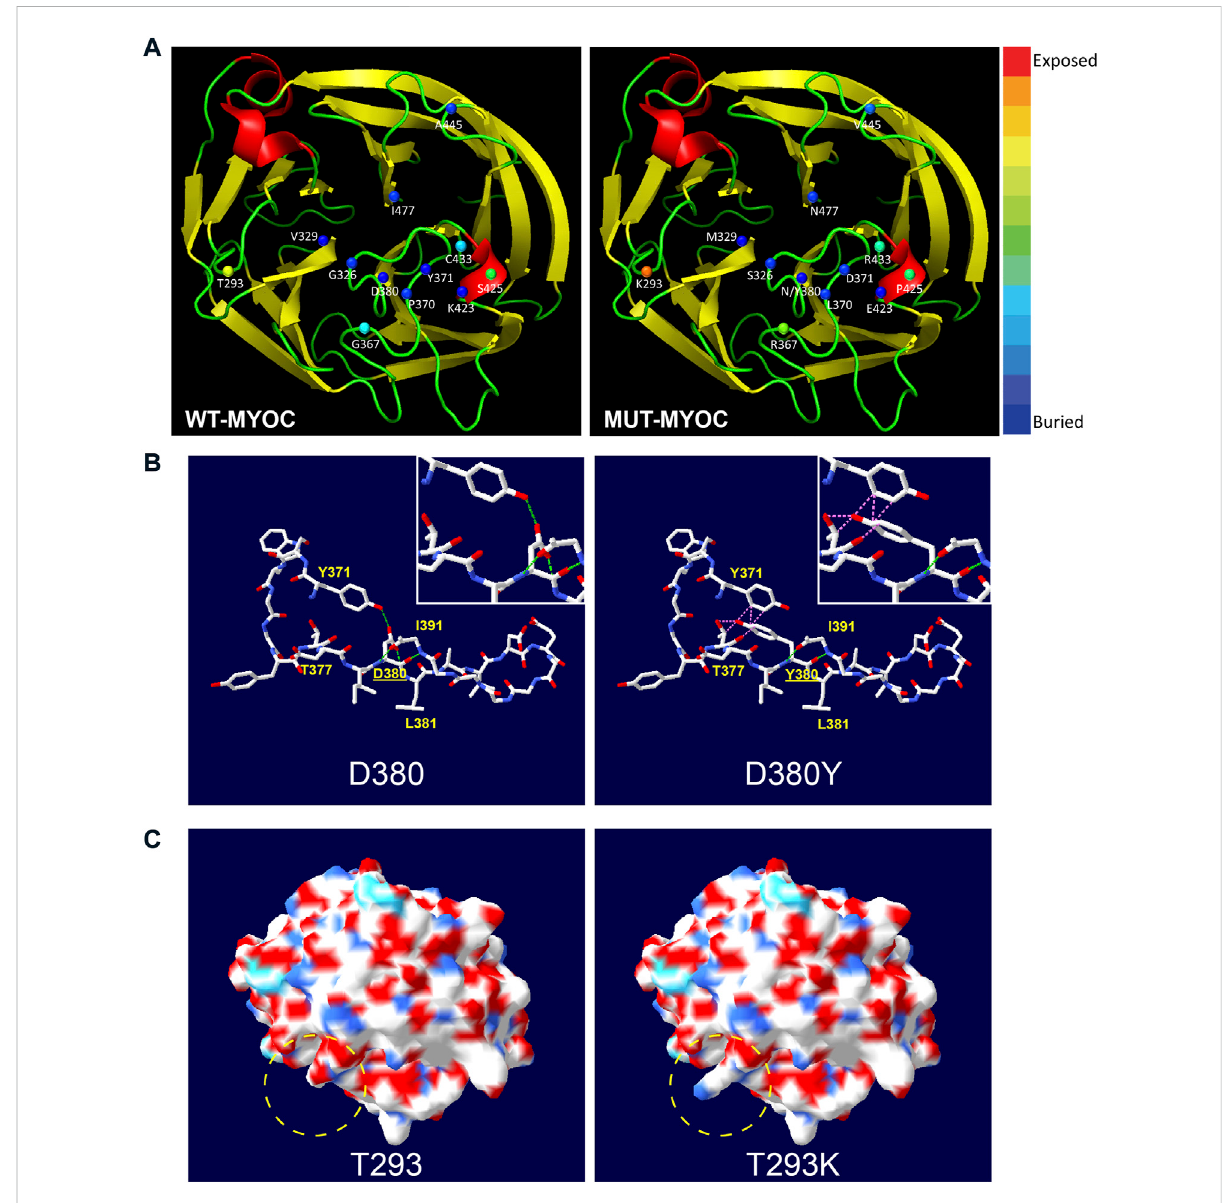
FIGURE 3 Structural alteration of myocilin-OLF induced by C-terminal MYOC variations using Swiss PdB Viewer. (A) Solvent accessibility analysis of WT- myocilin(leftpanel)andmutated-myocilin(rightpanel).Acartoonviewofthemyocilin-C-terminushomology(PDB:4WXQ)modelisshown.Twelve residues involved in 13 missense changes are represented as spheres colored according to solvent accessibility (using Swiss PdB Viewer, by which blue through red correspond to buried-through-exposed residues; see color bar). (B) Alteration of H-bonds and steric clashes induced by MYOC/p.D380Y mutation. H-bonds are drawn as green dotted lines, and clashes appear as pink dotted lines. (C) Changes in molecular surface including electrostaticpotential (SEP)and structureof MYOC/p.T293K mutation. The molecular surfaceiscoloredaccording to SEP using Swiss PdB Viewer, with red ‒ white-blue corresponding to acidic-neutral-basic potential. The yellow dotted circle represents the region of signi fi cant alteration of SEP and surface structure. See also Supplementary Figures